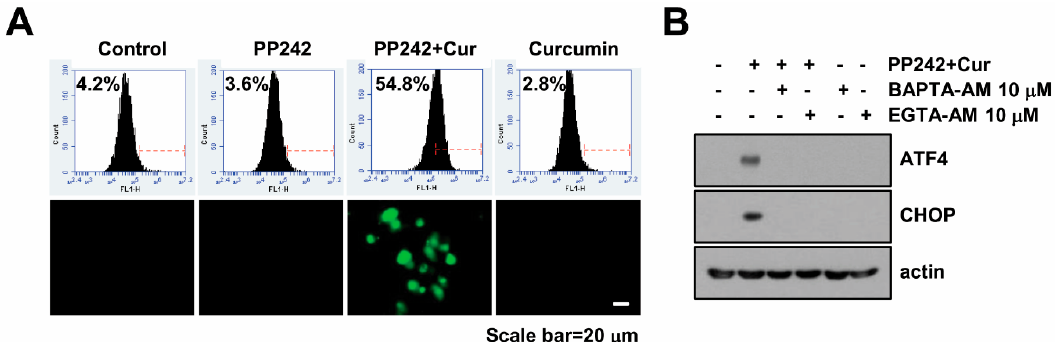
Figure 2. Combined PP242 and curcumin treatment induces intracellular Ca 2+ release in Caki cells. ( A ) Caki cell were treated with 0.5 µ M PP242 in the presence or absence of 20 µ M curcumin for 6 h. Cells were loaded with Flou-4/AM fluorescent dye, and flow cytometry (up panel) or fluorescence microscope (low panel) was used to detect calcium levels. ( B ) Caki cells were pre-treated with 10 µ M BAPTA-AM and 10 µ M EGTA-AM for 30 min and were then treated with PP242 plus curcumin for 9 h. Western blotting was used to detect protein levels of ATF4, CHOP and actin.